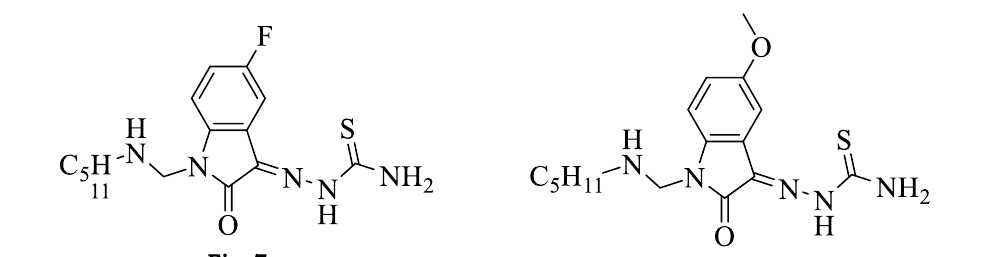
Fig. 7. Isatin derivatives as anti- Alzheimer (Sagnou et al., 2020)